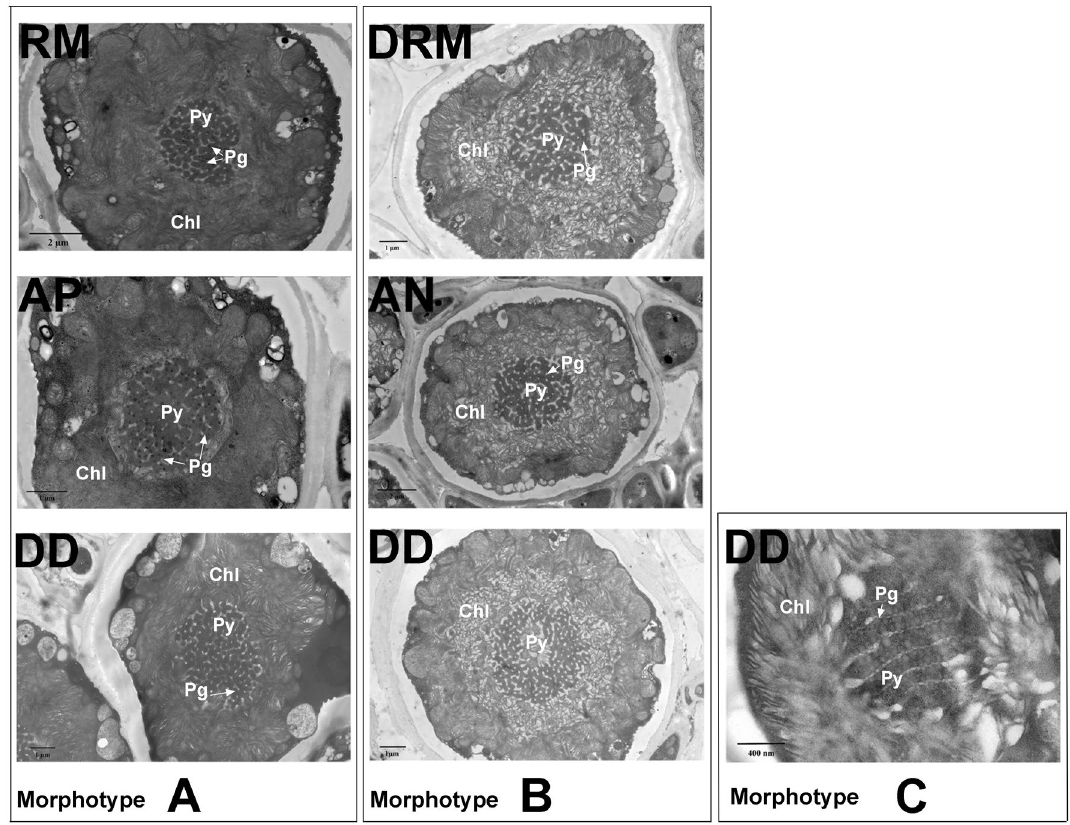
Figure 4. Cross-sections of the crustose lichens from Fuentidueña de Tajo obtained by TEM. Morphotype A of phycobionts found in Diploschistes diacapsis (DD), Acarospora placodiiformis (AP) and Rhizocarpon malenconianum (RM). Morphotype B of phycobionts found in Diploschistes diacapsis (DD), Acarospora nodulosa (AN) and Diplotomma rivas-martinezii (DRM). Morphotype C of phycobionts found in Diploschistes diacapsis (DD). Py pyrenoid; Pg Pyrenoglobuli, Chl Chloroplast. Bars: 400 nm, 1 μm, and 2